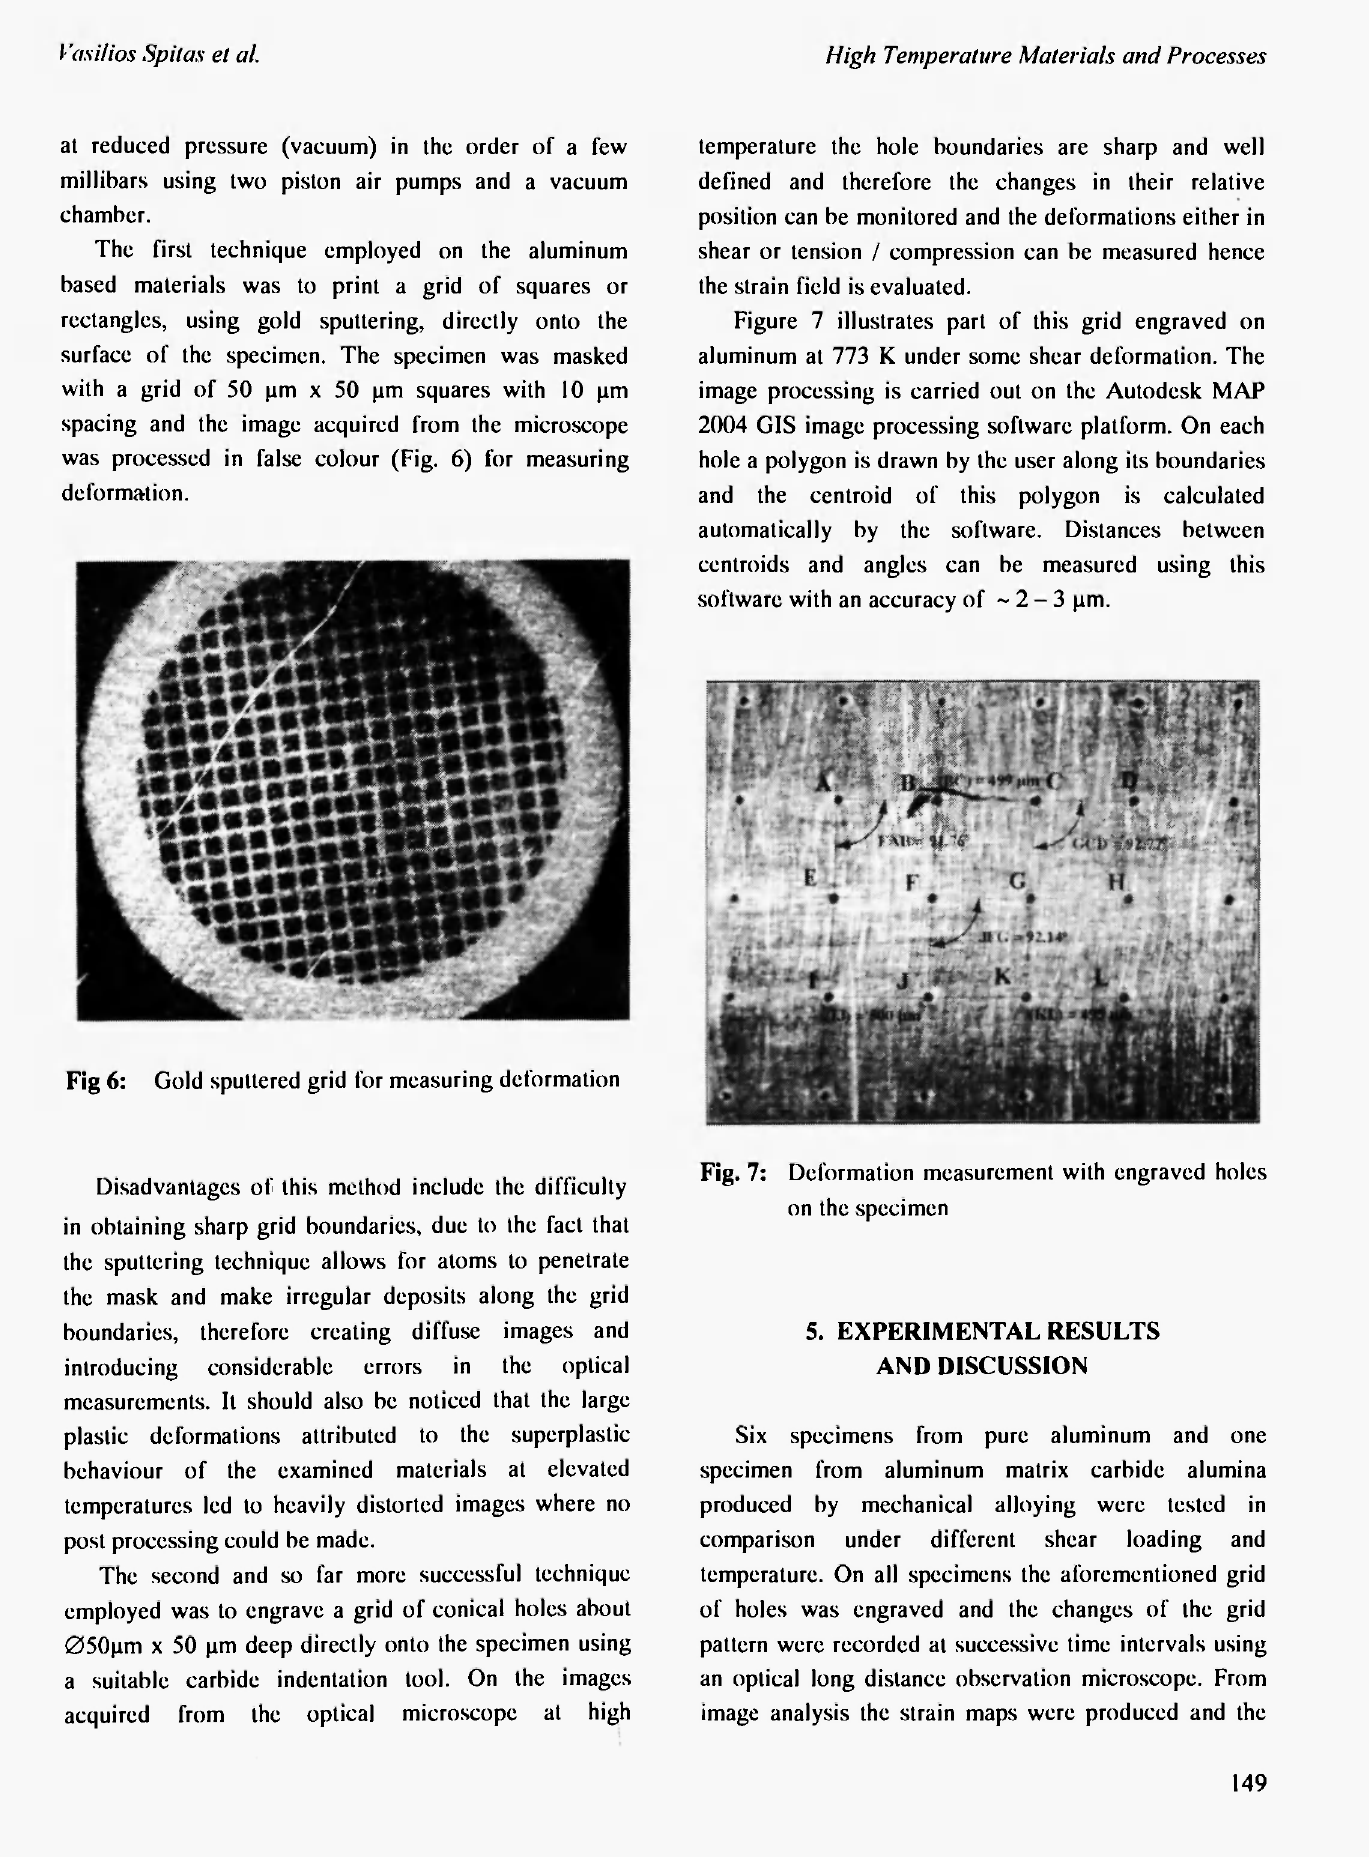
Fig. 7: Deformation measurement with engraved holes on the